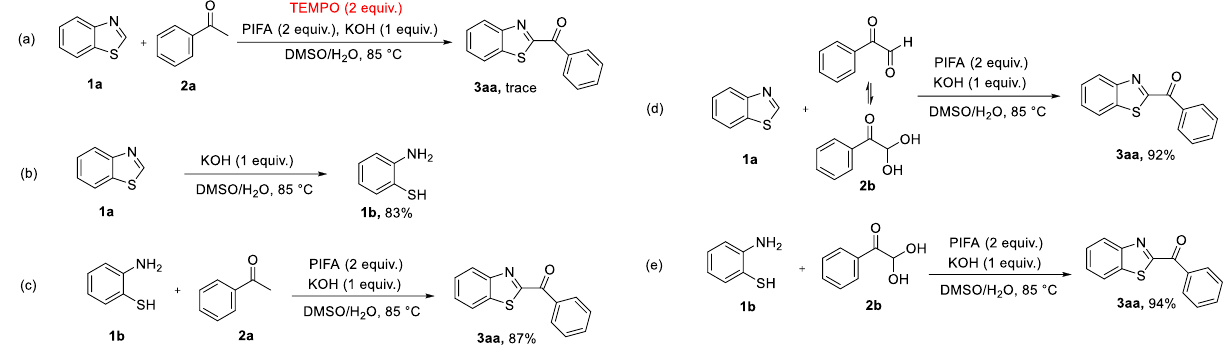
Figure 6. Plausible mechanism. 3. Conclusions In summary, we have developed a novel PIFA/KOH synergistically promoted C2- arylacylation of 2H -benzothiazoles using aryl methyl ketones as carbonyl sources. This